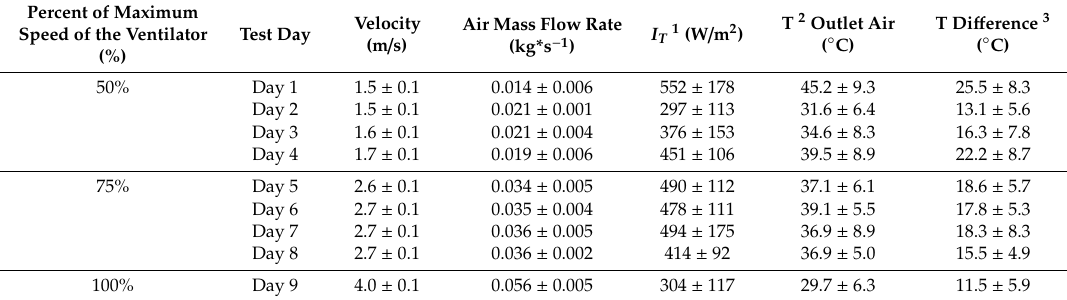
Table 5. The mean and standard deviation (SD) of the velocity, air mass flow rate, solar radiation on the collector surface, outlet air temperature, and the temperature di ff erence between the outlet air and the inlet air of the SAH on each test